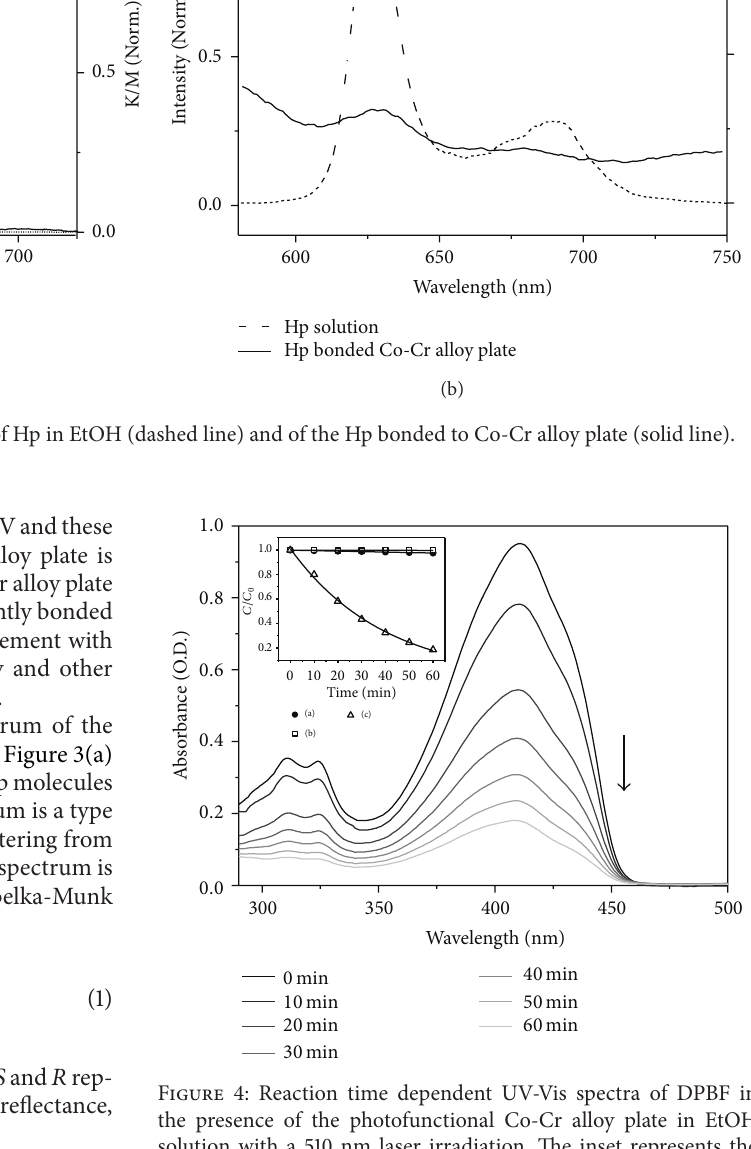
Figure 4: Reaction time dependent UV-Vis spectra of DPBF in the presence of the photofunctional Co-Cr alloy plate in EtOH solution with a 510 nm laser irradiation. The inset represents the ratio between the after decomposition reaction O.D. (𝐶) and the initial O.D. (𝐶 0 ) of DPBF as function of irradiation time: (a) DPBF only under the light, (b) DPBF with the photofunctional Co-Cr alloy plate in the dark condition, (c) DPBF with the photofunctional Co- Cr alloy plate under the